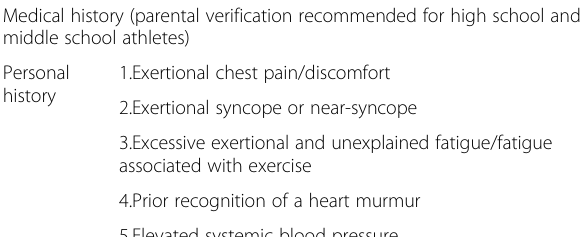
Table 1 The 14-element AHA recommendation for pre- participation cardiovascular screening of competitive